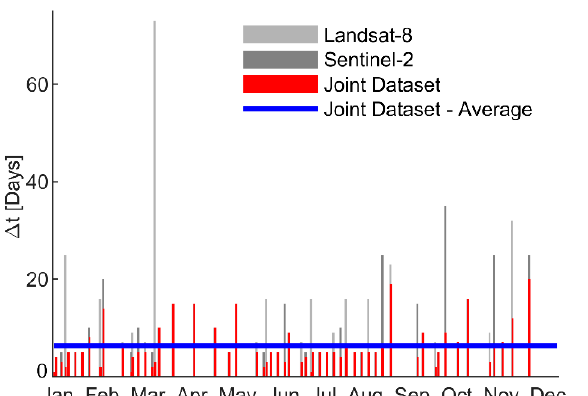
Figure 9. Number of days between two usable images of the L8 and S2 datasets taken individually and of the merged dataset in 2019.